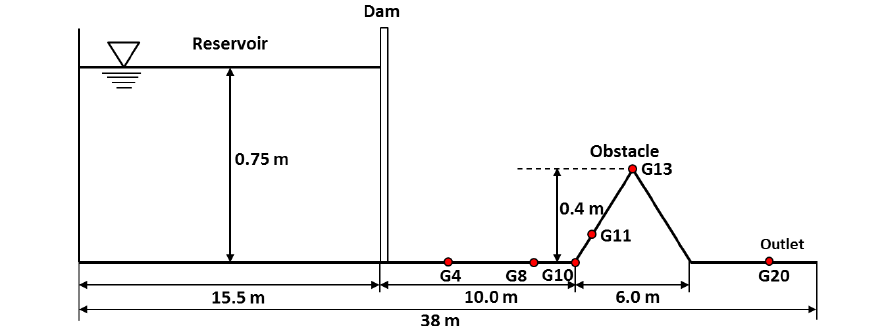
Figure 6. The experimental setup of dam break flow over triangular obstacle [44].